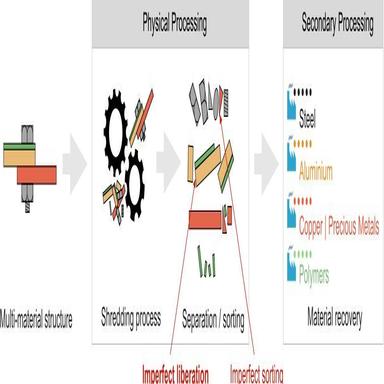
Typical shredder-based recycling flowsheet consisting of a physical and secondary processing stage. High material liberation and separation rates are crucial for maximizing subsequent material recovery rates, as materials entering the wrong secondary processing route might not be recoverable. This paper focuses on material liberation aspects of physical processing. Figure adapted from.